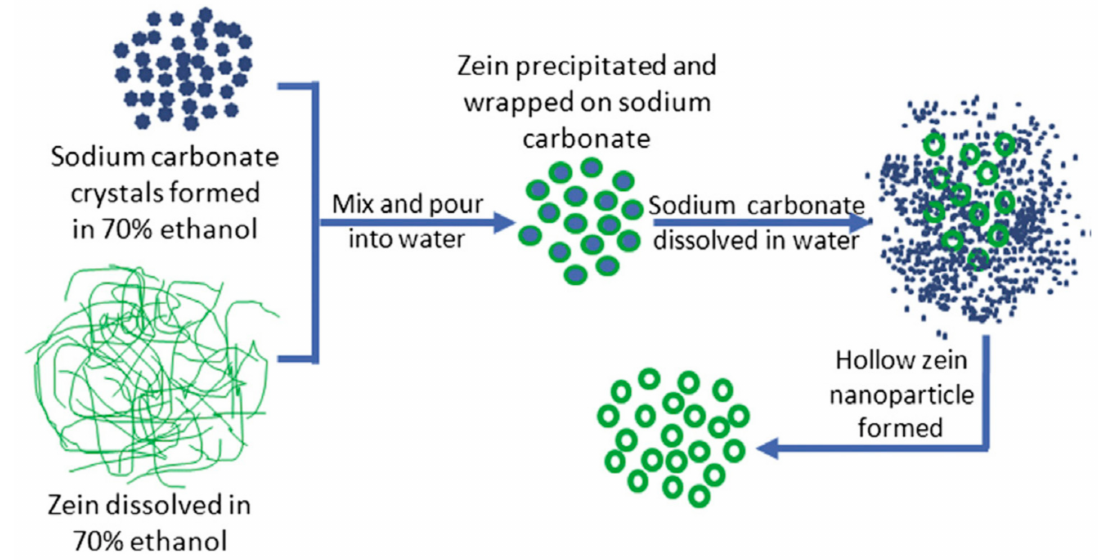
Figure 10. Process of obtaining the hollow zein nanoparticles (nanocapsules). Reprinted with permission from ref. [72]. Copyright 2013